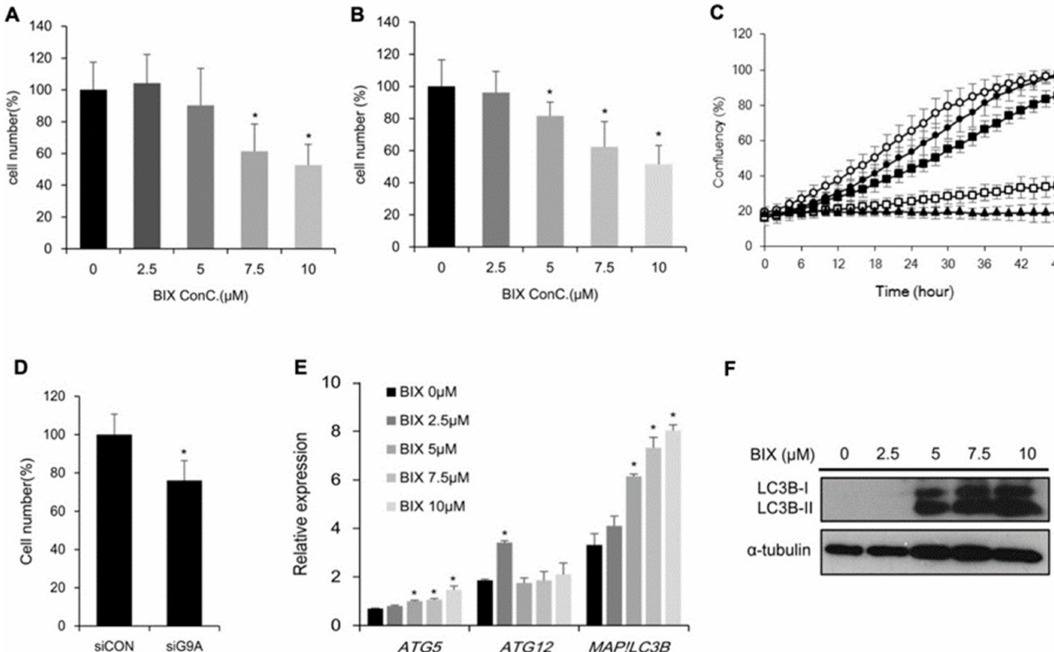
Figure 2. Suppression of cell proliferation and induction of autophagy by EHMT2 inhibition. ( A and B ) MTT assay of H1299 ( A ) and A549 ( B ) groups treated with BIX01294 (BIX) for 48 h was presented relative to the non-treated group. * p < 0.05 versus BIX non-treated group. ( C ) Cell confluency was measured by the IncuCyte Zoom live-imaging system in BIX-treated H1299. ( D ) MTT assays of H1299 cells were conducted after transfection with siCON or small interfering RNA targeting EHMT2 (siEHMT2) for 48 h. * p < 0.05, siCON versus siEHMT2 group. ( E ) Expression of the autophagy-related genes ATG5 , ATG12 , and MAP1LC3B was measured in BIX treated H1299. * p < 0.05 against 0 µ M BIX treatment. ( F ) LC3B protein levels were analyzed by Western blotting after BIX treatment for 48 h in H1299. α -Tubulin levels are shown as loading